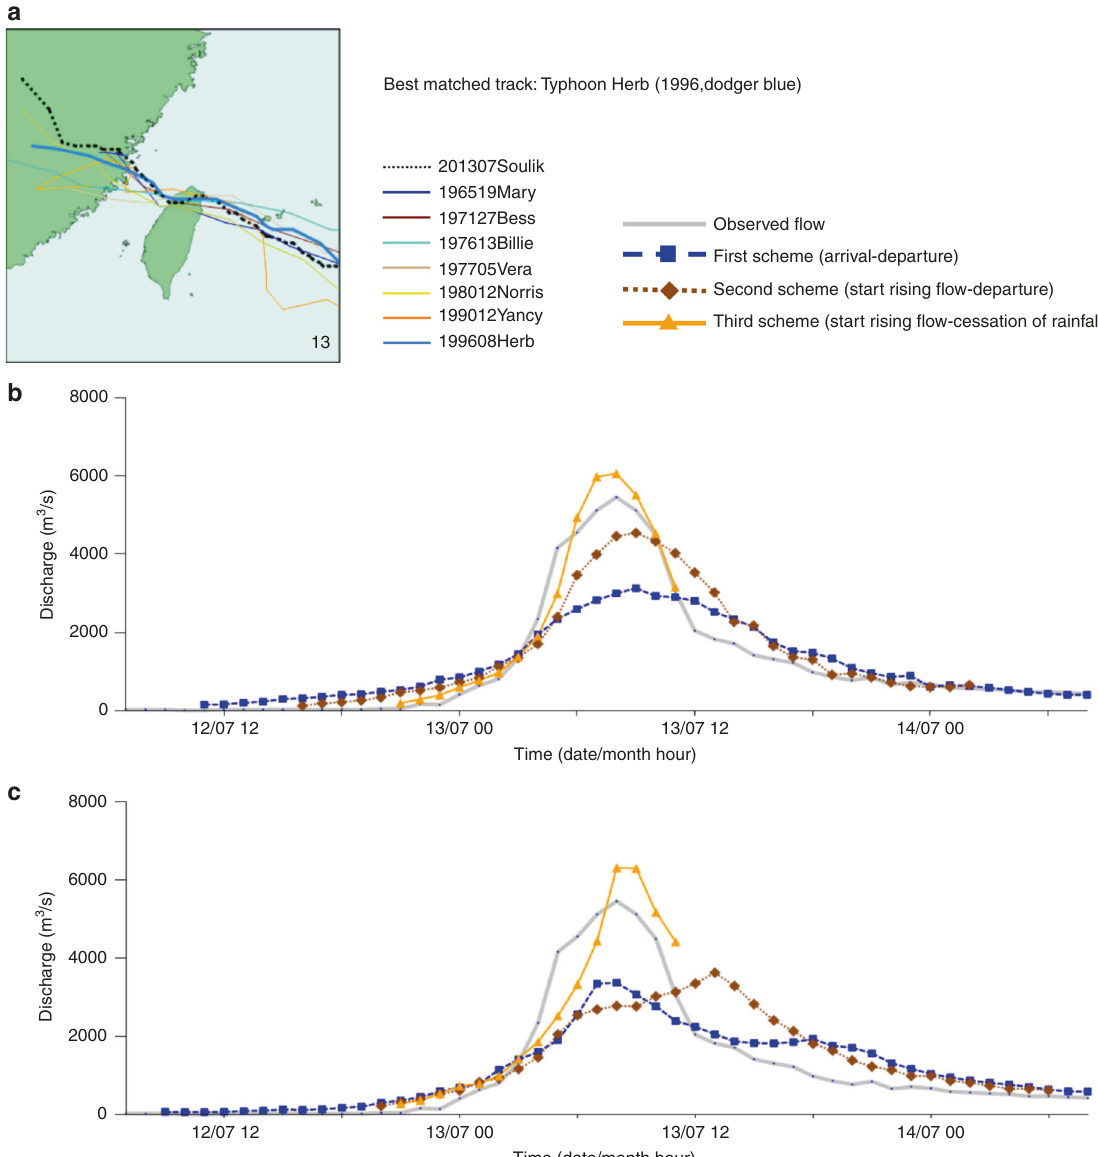
Fig. 8 Predicted fl ood hydrographs for Typhoon Soulik. Predictions were made using two fl ow characteristic curve selection strategies under three typhoon duration schemes. a Actual typhoon tracks grouped in cluster #13. This is the best matched cluster while Typhoon Herb is the best matched track. b Predicted fl ood hydrographs using the fi rst selection strategy. c Predicted fl ood hydrographs using the second selection